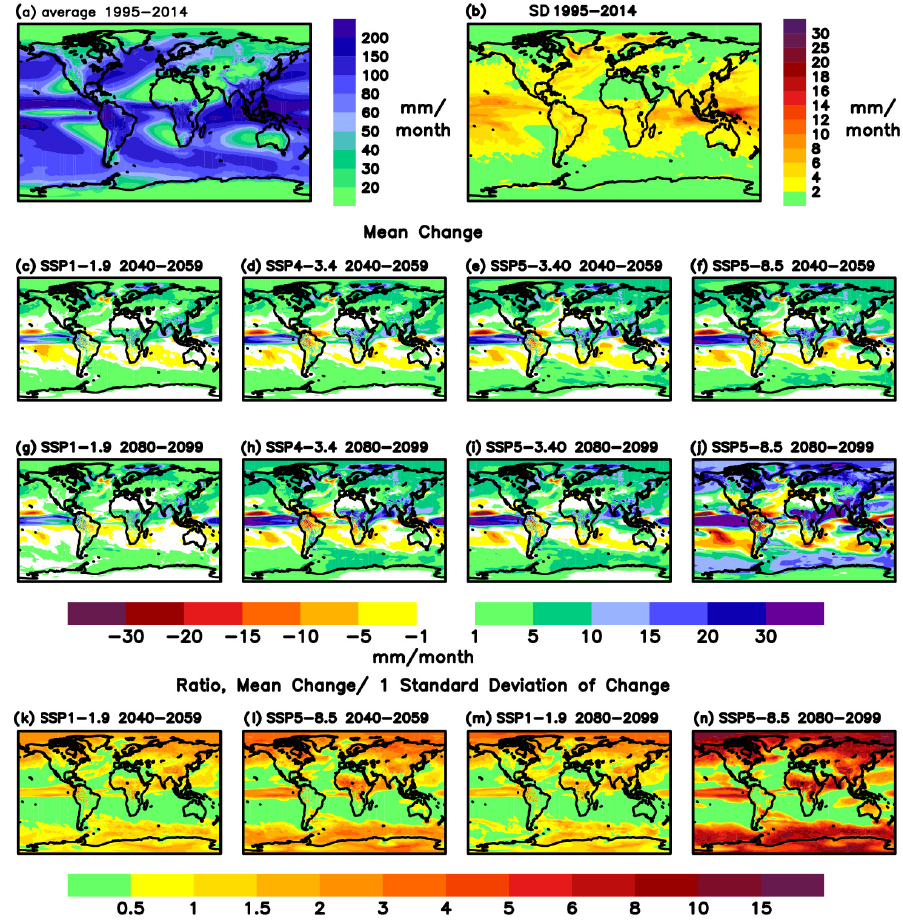
Figure 4. Same as Fig. 3 but for annual mean precipitation. Precipitation changes that are not marked in color are either not significant at the 95% significance level or are small (below ± 1mm per